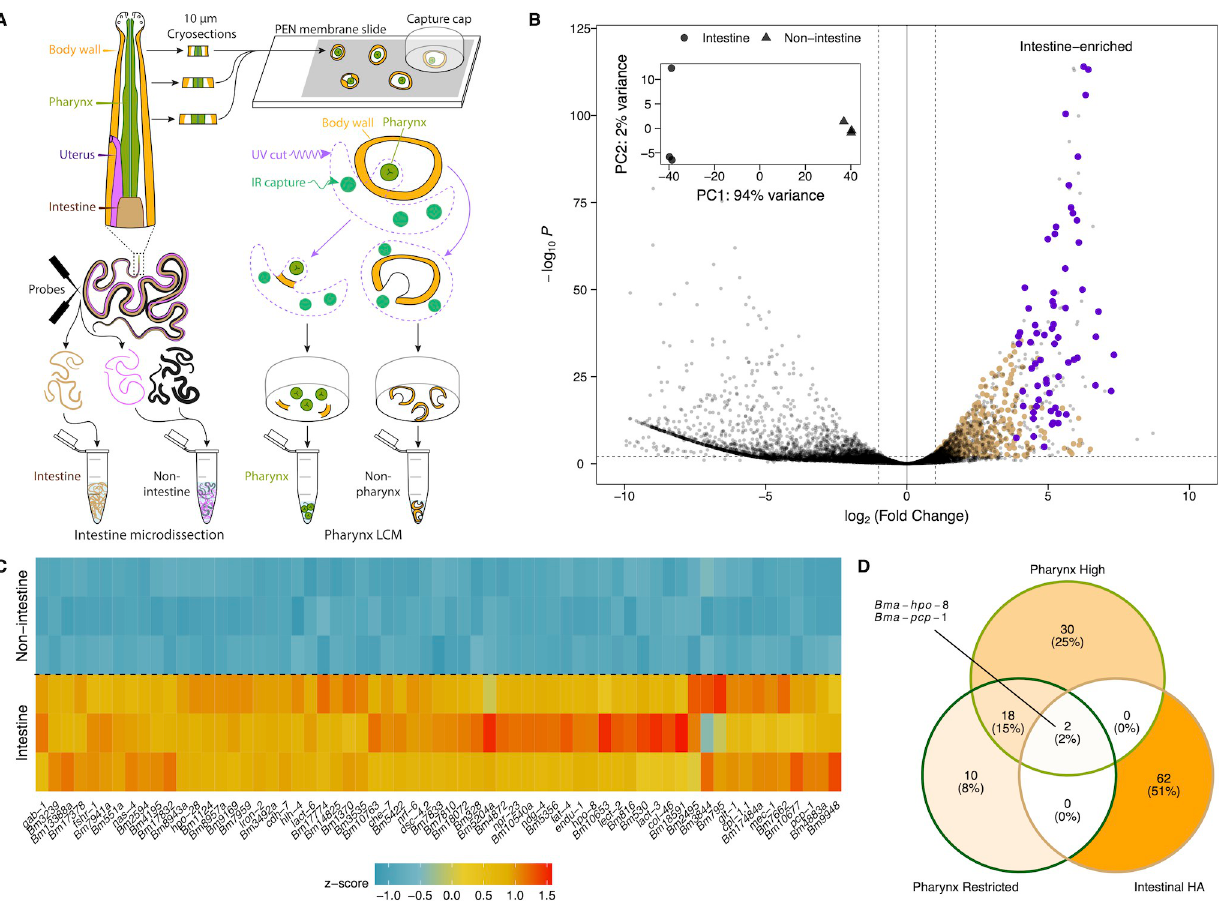
Fig 6. Alimentary-specific transcriptomics of B . malayi adult female pharynx and intestine. (A) Graphical representation of dissection and laser capture microdissection strategies to recover tissues of the lower (intestine) and upper (pharynx) alimentary canal. (B) Volcano plot highlighting intestinally-enriched transcripts from paired intestinal and non-intestinal samples of three biological replicates (individual parasites). Transmembrane proteins are considered candidate hidden antigens if they are intestine-enriched (brown), with a prioritized subset that is intestine-restricted (purple). (C) Expression heatmap of 64 prioritized intestine-restricted hidden antigens (p-value < 0.01, > 1 transmembrane domain, mean intestinal TPM > 100, mean intestinal:non-intestinal TPM ratio > 10). z-scores were generated from vst-transformed counts. (D) Overlap of candidate intestinal hidden antigens, highly-expressed pharyngeal genes (top 50 mean pharyngeal TPM among genes with > 100 TPM for each of three replicates), and pharyngeal genes with more tissue-restricted profiles.